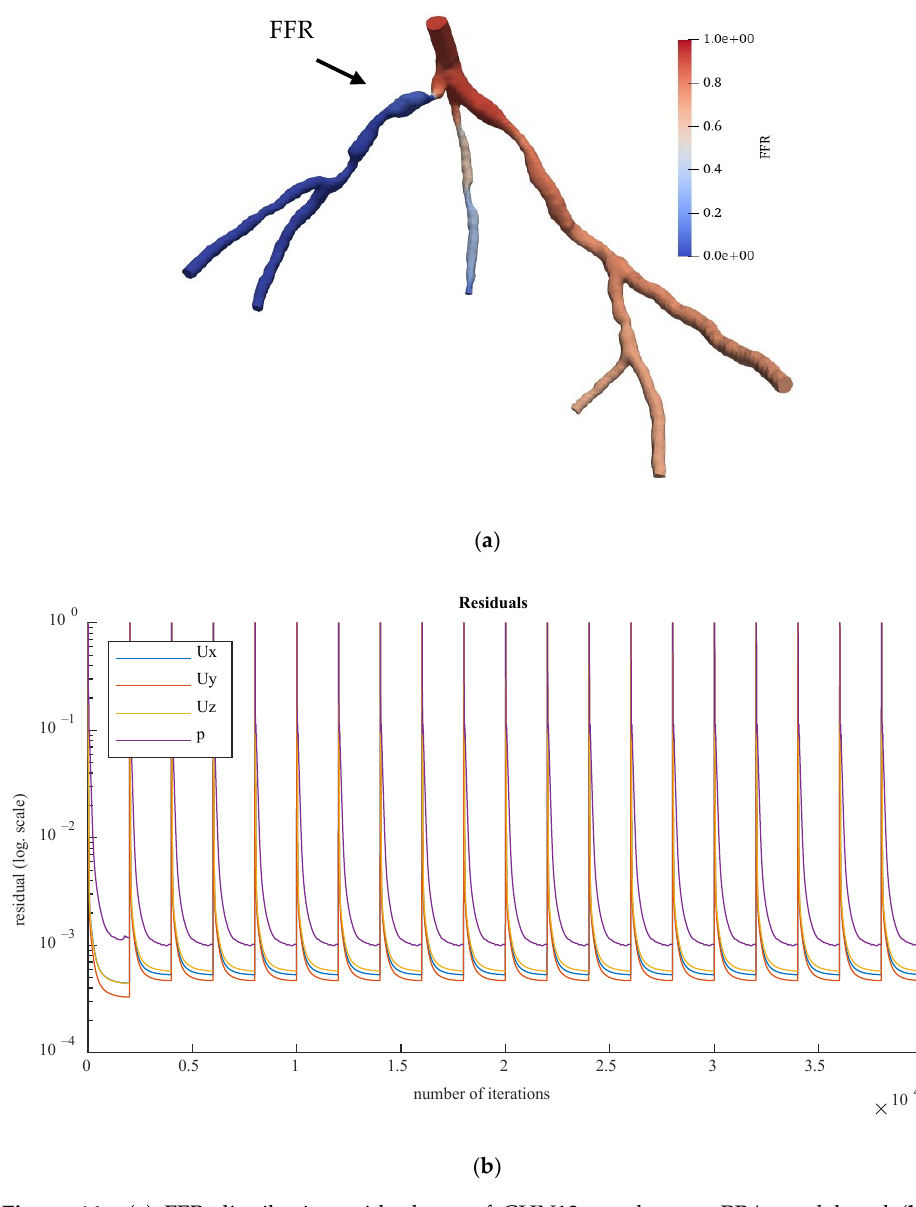
Figure 16. ( a ) FFR distribution with shape of CHN13 steady-state PBA model and ( b ) PBA residual history.